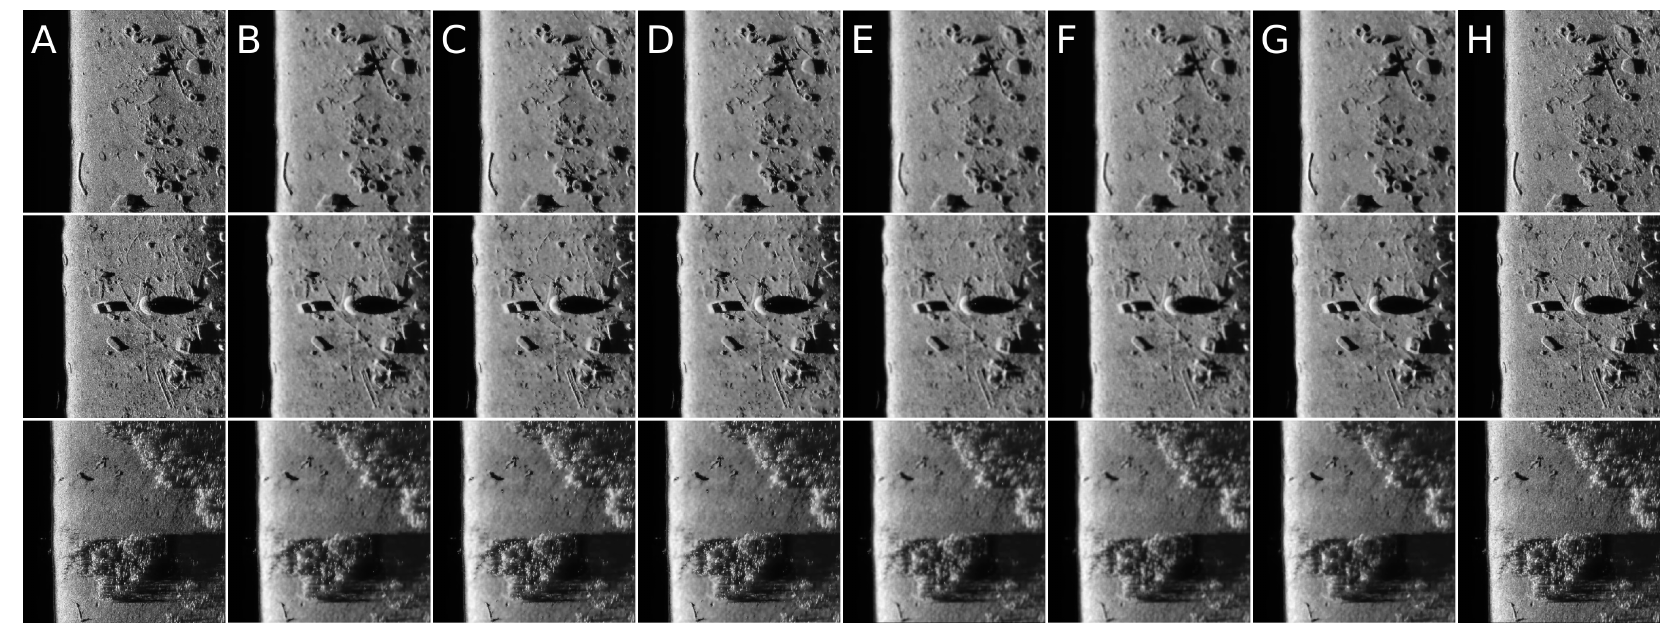
Figure 16. Filtering results comparison for three different real side scan sonar images: ( A ) Original image; ( B ) Frost; ( C ) Kuan; ( D ) Lee; ( E ) Lee enhanced; ( F ) Mean; ( G ) Median; and ( H )